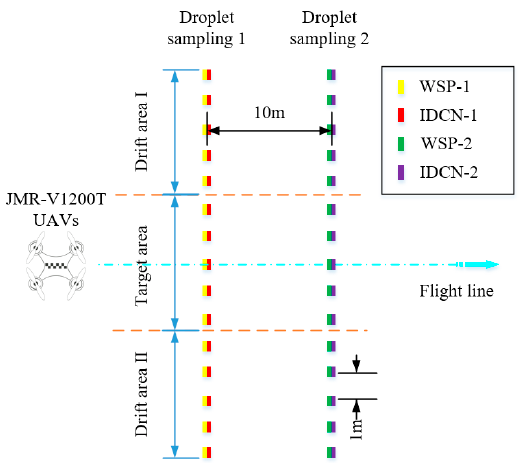
Figure 10. Schematic diagram of the test. WSP: Water Sensitive Paper; IDCN: Intelligent Droplet Collection Node.